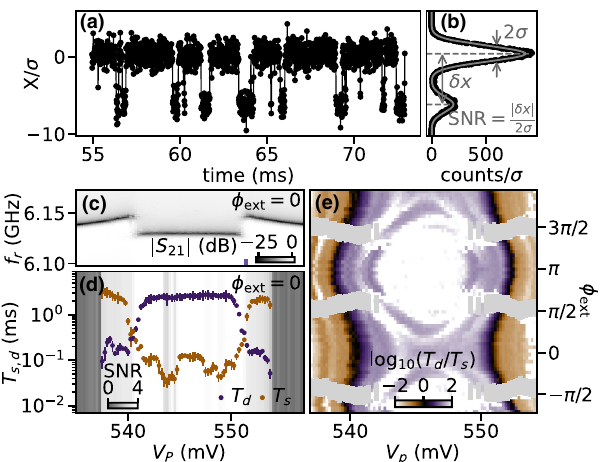
FIG. 7. The dependence of the parity lifetimes on V P and φ ext for device B. (a) A 18-ms cut of a continuously measured time trace integrated in time bins of t int = 11.4 μ s, revealing jumps between two distinct states. X is the common axis onto which the quadratures of the outgoing microwave field are rotated to obtain the highest SNR, which takes a value of 3.3 here. (b) A one-dimensional histogram of the response in (a) (black) and the best fit of a double Gaussian line shape (gray). The separation of their centers δ x and their width σ together define the SNR. The ratio of their amplitudes determines the ratio of the lifetimes. For (a) and (b), V P = 551.4 mV and φ ext = 0. (c) The V P dependence of | S 21 | at φ ext = 0. (d) The V P dependence of the extracted life- times at φ ext = 0. The markers indicate the mean, while the error bars indicate the maximum and minimum values of ten consec- utive 2-s time traces. The SNR is shown in gray scale in the background. For points where SNR < 1, the extracted lifetimes ( T / T ) versus are discarded. (e) A two-dimensional map of log d s 10 V P and φ ext , extracted from a 2-s time trace for each pixel. White pixels indicate points at which SNR < 1, while gray regions indi- cate where the resonator frequencies of singlet and doublet states overlap and thus cannot be